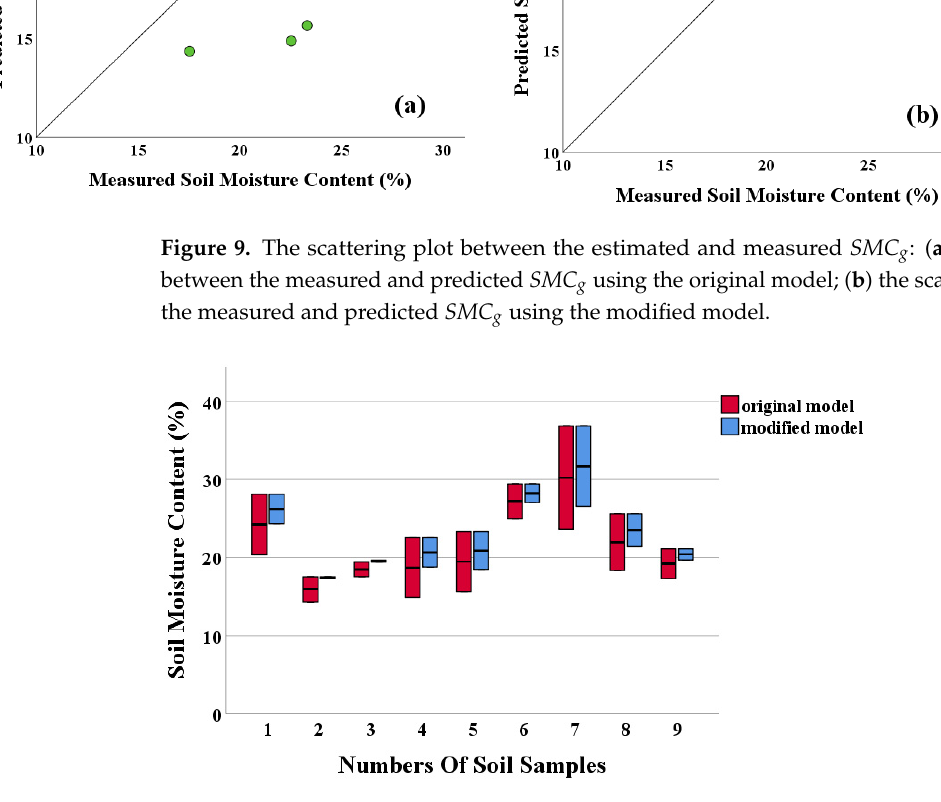
Figure 9. The scattering plot between the estimated and measured SMC g : ( a ) the scattering plot be- tween the measured and predicted SMC g using the original model; ( b ) the scattering plot between the measured and predicted SMC g using the modified model.